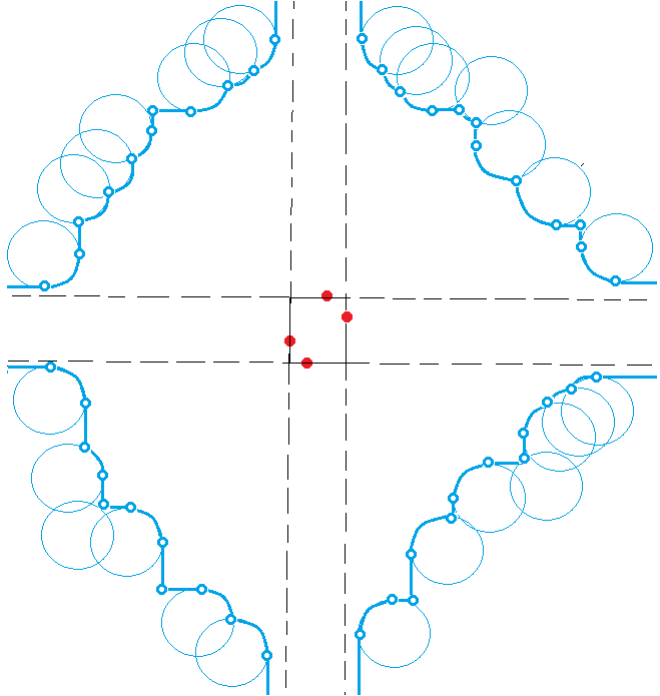
Figure 21. In each region, the circles define a dominating envelope C , which is a sequence of arcs and horizontal or vertical segments. Two consecutive arcs or segments define a breakpoint on C